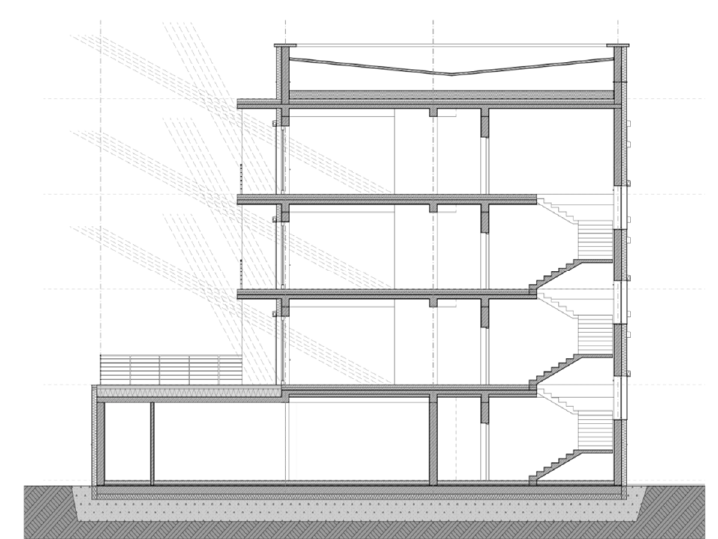
Figure 3. Transverse cross-section of the building with extended ground-floor bays due to the